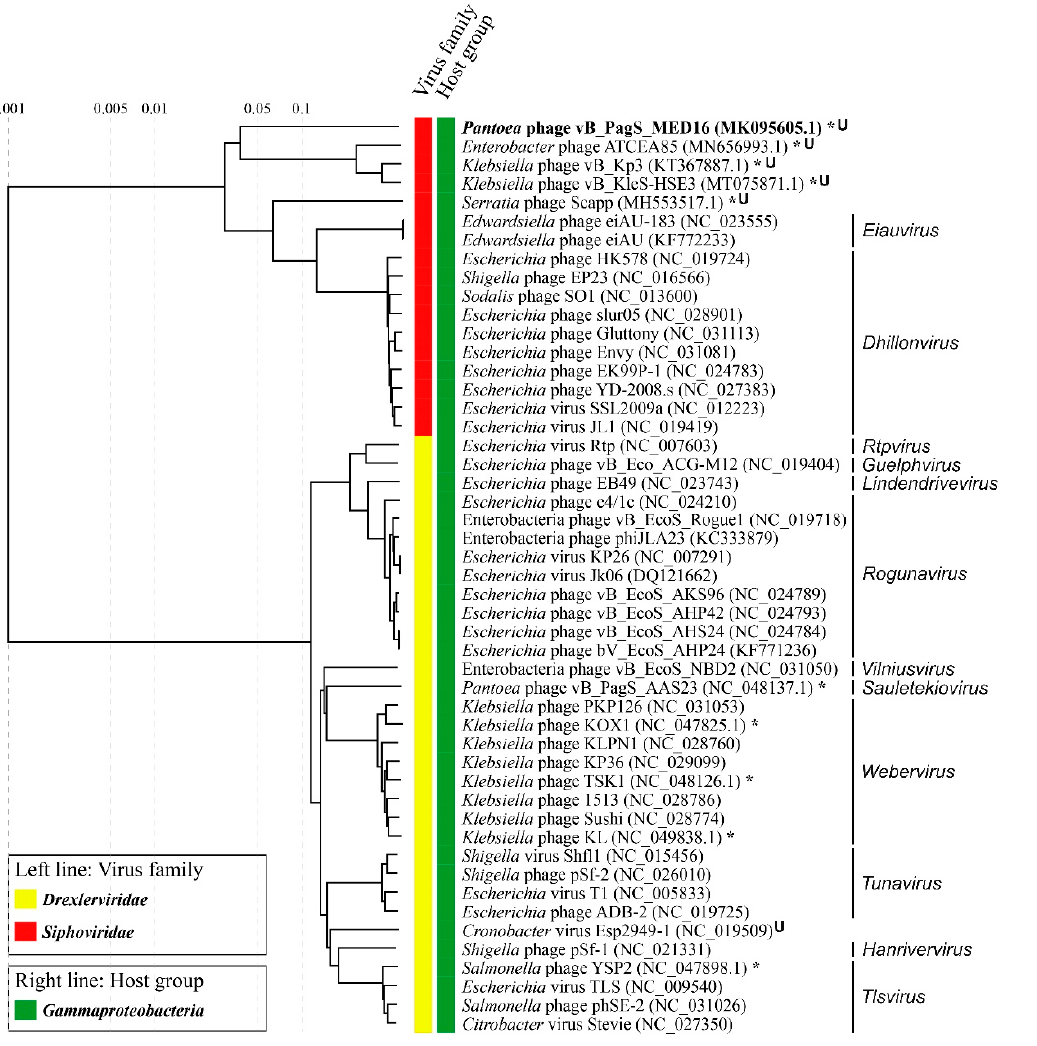
Figure 7. ViPTree generated proteomic tree of Pantoea phage vB_PagS_MED16 and dsDNA viruses represented in the rectangular view. The tree was constructed by BIONJ based on genomic distance matrixes and mid-point rooted. Branch lengths are logarithmically scaled from the root of the entire proteomic tree. The numbers at the top represent the log-scaled branch lengths based on the SG (normalized tBLASTx scores) values.